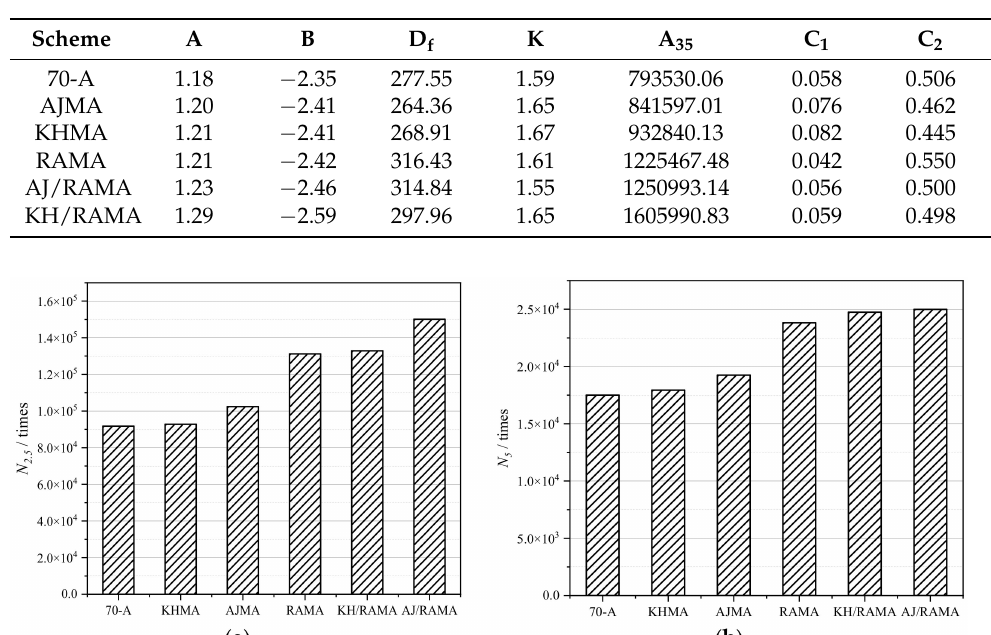
Table 6. LAS test parameters.